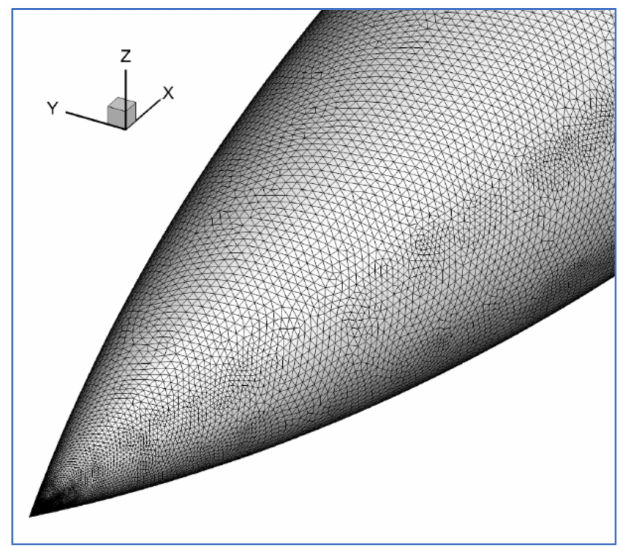
Figure 6. Surface mesh at the tip region. Grid U1.